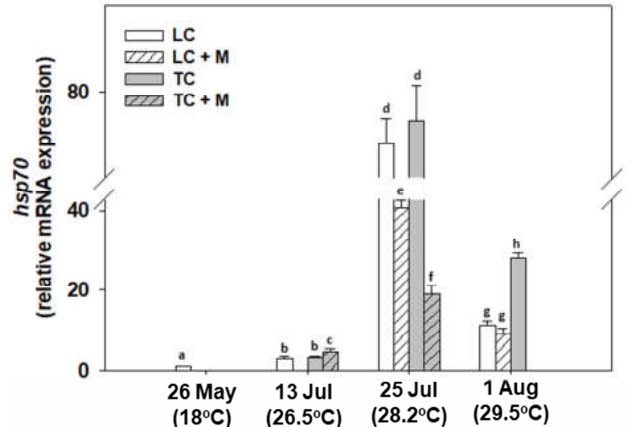
Figure 6. Relative hsp70 mRNA expression levels in the mantle of M. galloprovincialis specimens, either infected with Martelia spp. (M) or not. Samples were collected from Thermaikos Gulf during a summer heatwave both from traditional culture-Bouchot (TC) and long-line system (LC). Values represent means ± SD; n = 5 preparations from different animals. Lower case letters indicate statistically significant differences ( p < 0.05) between